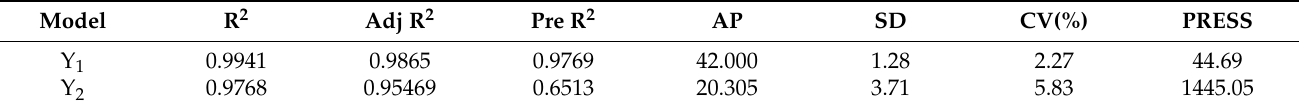
Table 4. The related statistical criteria values of